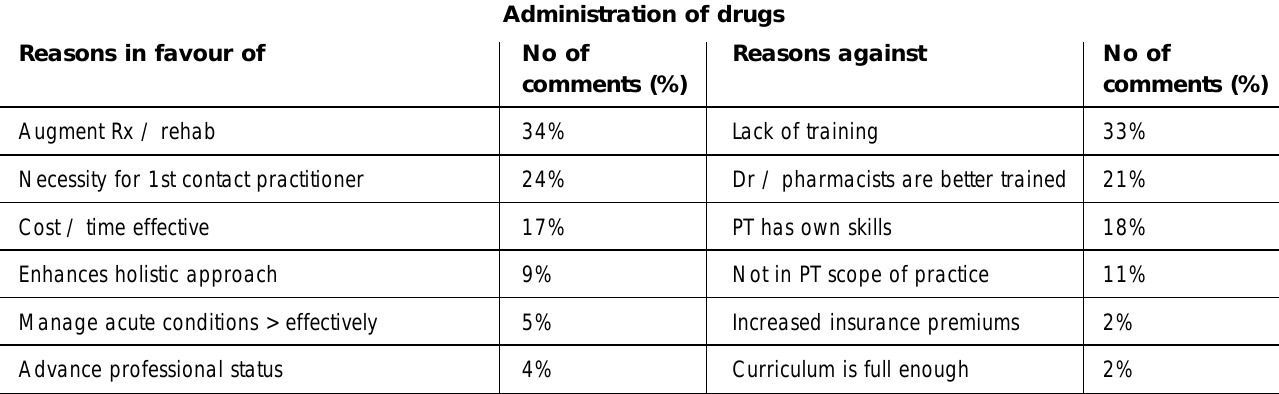
Table 2: Comments regarding administration